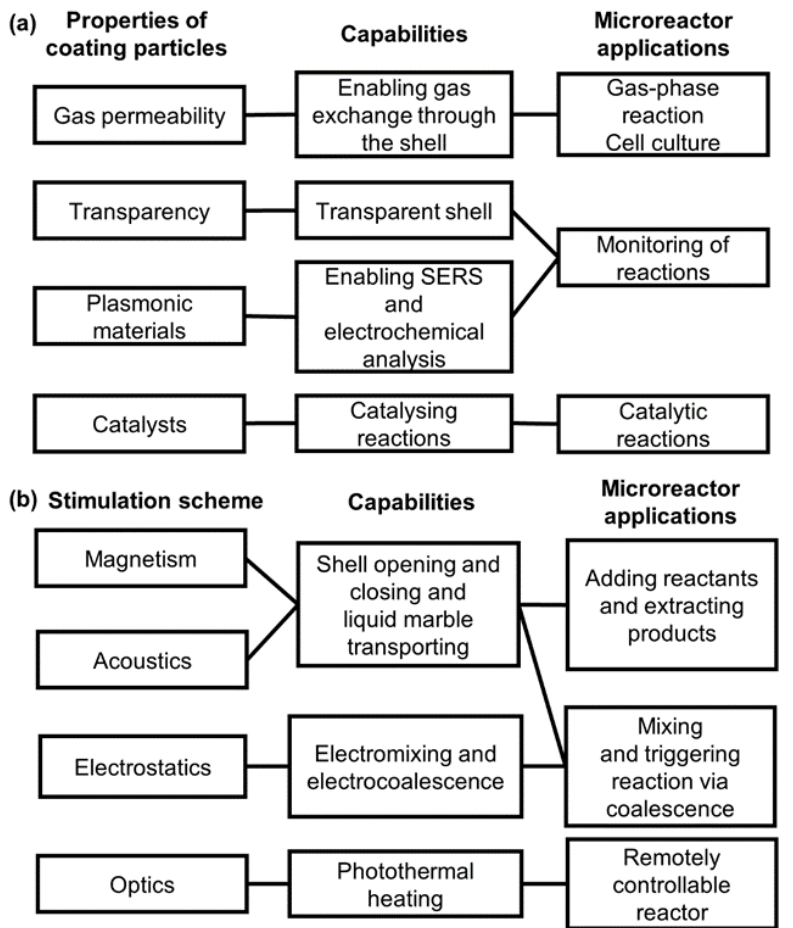
Figure 1. Applications of liquid marble-based microreactors. ( a ) Properties of coating particles and microreactor applications. ( b ) Stimulation schemes and microreactor applications. SERS: by surface-enhanced Raman scattering spectroscopy.